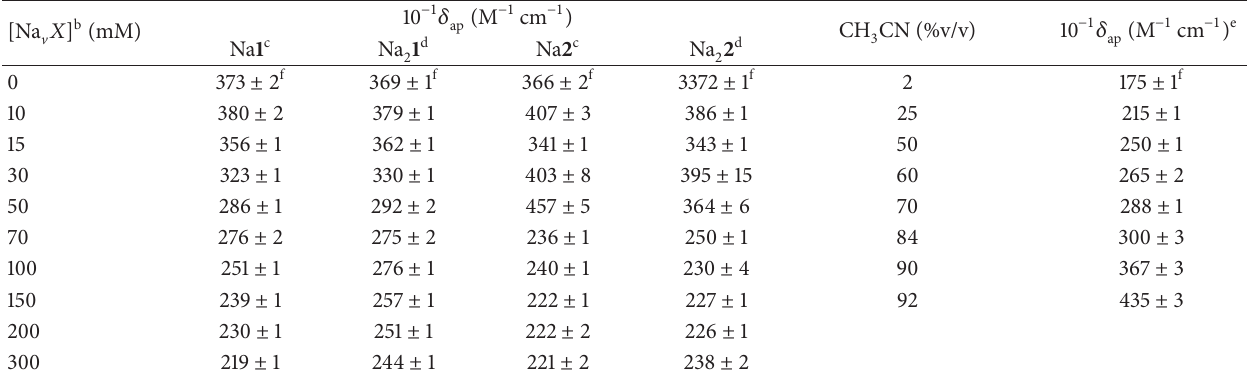
Table 1: The values of 𝛿 , calculated from (1) for the piperidinolysis of 3 − under the variety of experimental conditions a . ap [Na V 𝑋 ] b (mM)